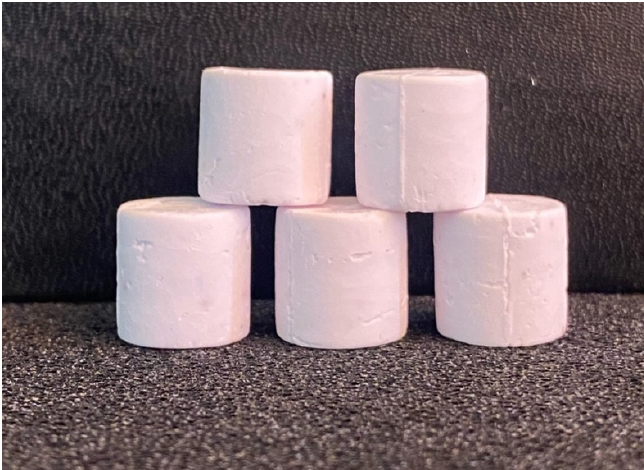
Figure 17. Samples after sintering. The compression strength of these articles was measured using the FP-100/1 Heckert testing machine (traverse speed of 10 mm/min). As a result, the average (for five samples) value of the compression strength was 240 ± 5 MPa. This value corresponds to regular compression strength of engineering ceramics